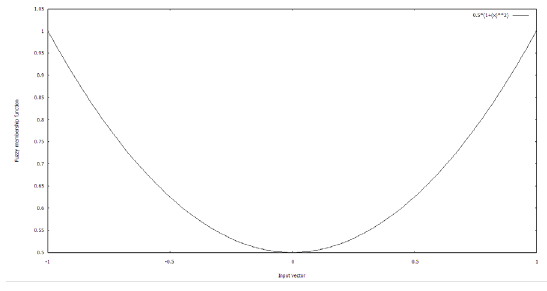
Fig. 6. Characteristics of fuzzy membership function at k = 1.